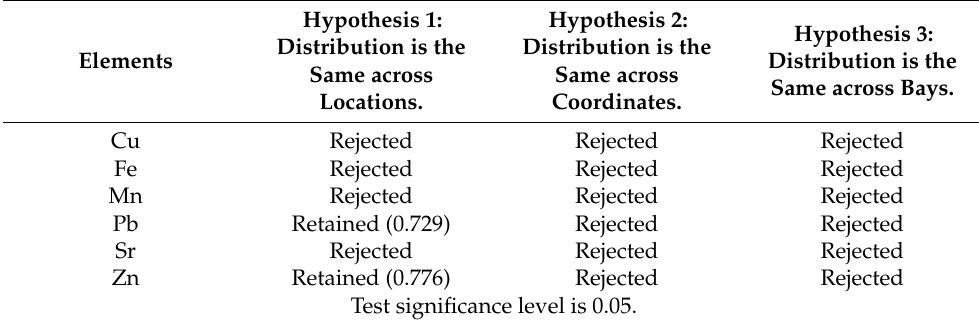
Table 8. Hypotheses assessed using Mann–Whitney U-test and Kruskal–Wallis test for sand beaches